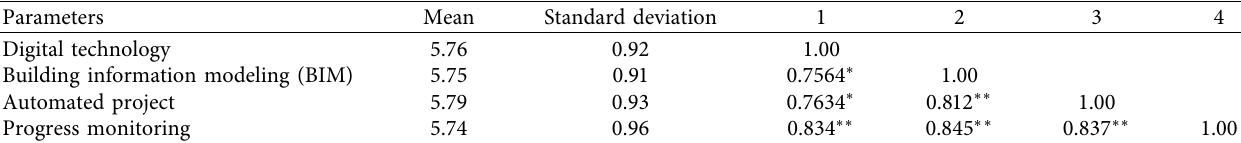
Figure 4: Descriptive statistics and Pearson correlation analysis of digital twin and BIM. Table 3: Descriptive statistics and Pearson correlation analysis.